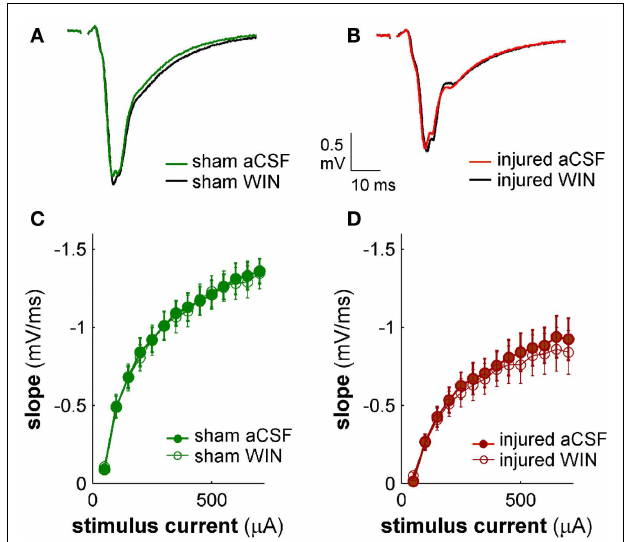
FIGURE 13 | Cannabinoid agonistWIN55,212-2 does not affect excitatory transmission in CA1 field potential recordings . CA1 SR-evoked and recorded field potentials. (A,B) Ten-trial average SR-evoked SR field potentials for representative sham (A) and injured (B) mouse brain slices in normal aCSF and in aCSF containing 100nMWIN55,212-2. Stimulus 300 µ A.WIN55,212-2 did not have a significant effect on the initial portion of the field potentials in either sham or injured mouse brain slices, indicating thatWIN55,212-2 did not significantly affect SR-evoked excitatory responses in SR. (C,D) Group average field potential slope versus stimulus current for slices from sham (C) and injured (D) mice.The slope in the early portion of an SR field potential is a measure of excitatory synaptic transmission.WIN55,212-2 did not significantly affect either sham or injured field potential slopes at any stimulus strength tested, again indicating that WIN did not significantly affect SR-evoked excitatory synaptic transmission. Wilcoxon Signed Rank P values > 0.05 for all stimulus strengths. Sham n = 8, injured n = 8; data plotted as mean ±